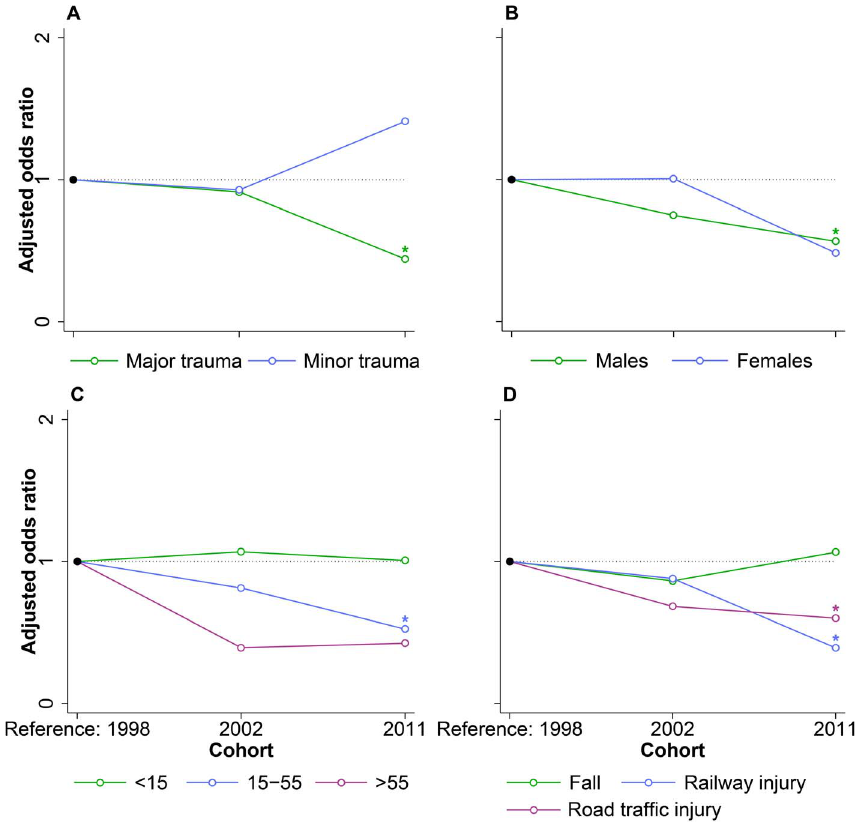
Figure 4. Comparison of early hospital mortality odds ratios in subgroup analyses. Odds ratios are early hospital mortality odds ratios. A. Major trauma was defined as ICISS , 0.9. The model was adjusted for sex, age, mechanism of injury, and ICISS. B. The model was adjusted for age, mechanism of injury, and ICISS. C. The model was adjusted for sex, mechanism of injury, and ICISS. D. The model was adjusted for sex, age, and ICISS. Abbreviations: ICD International Classification of Disease, ICISS ICD-derived Injury Severity Score. *P-value , 0.05, compared to the reference category.